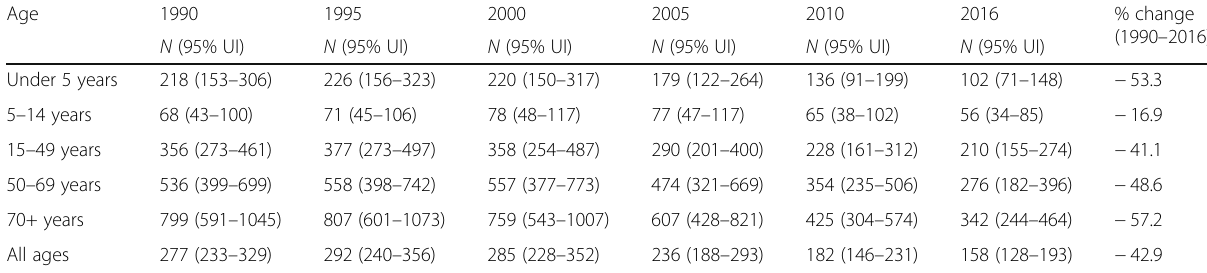
Table 2 Incidence rate of tuberculosis (with 95% uncertainty interval, UI) by age in Nigeria, 1990 – 2016 (per 100,000 population)